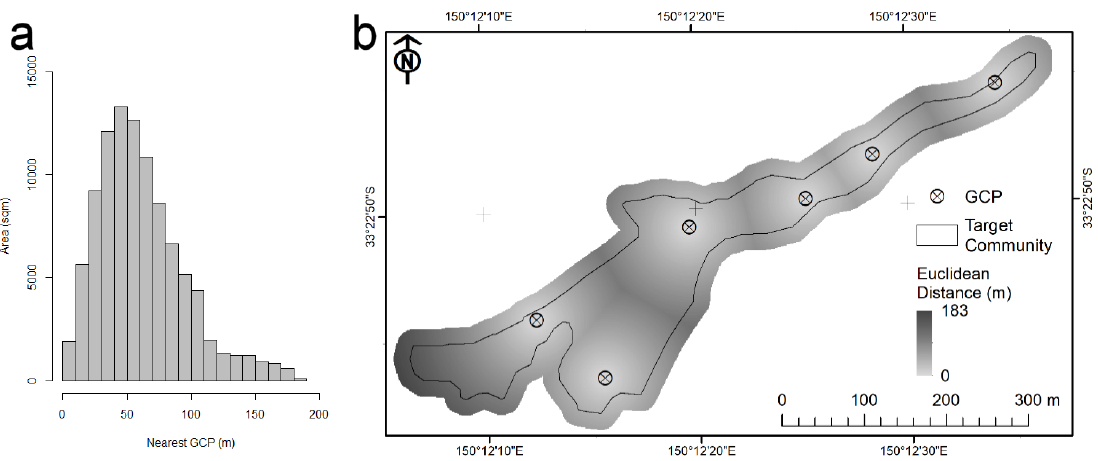
Figure 5. ( a ) Histogram of distance to nearest GCM mark (10 m bins) for 1 m 2 cells covering the buffered study site. ( b ) Locations of each ground control point with distance.